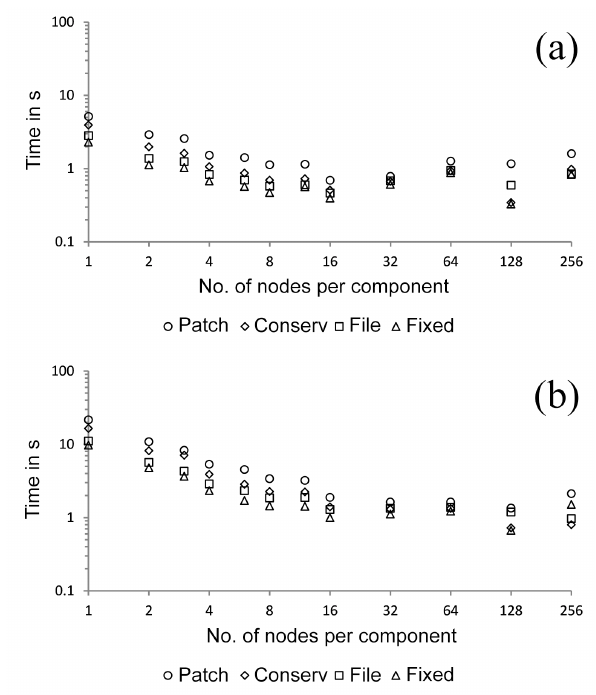
Figure 3. Time required for global search and calculation of weights for different interpolation methods in both directions be- tween (a) an ICONR2B06 and 405 × 405 cubed-sphere grid and (b) an ICONR2B07 and 810 × 810 cubed-sphere grid.